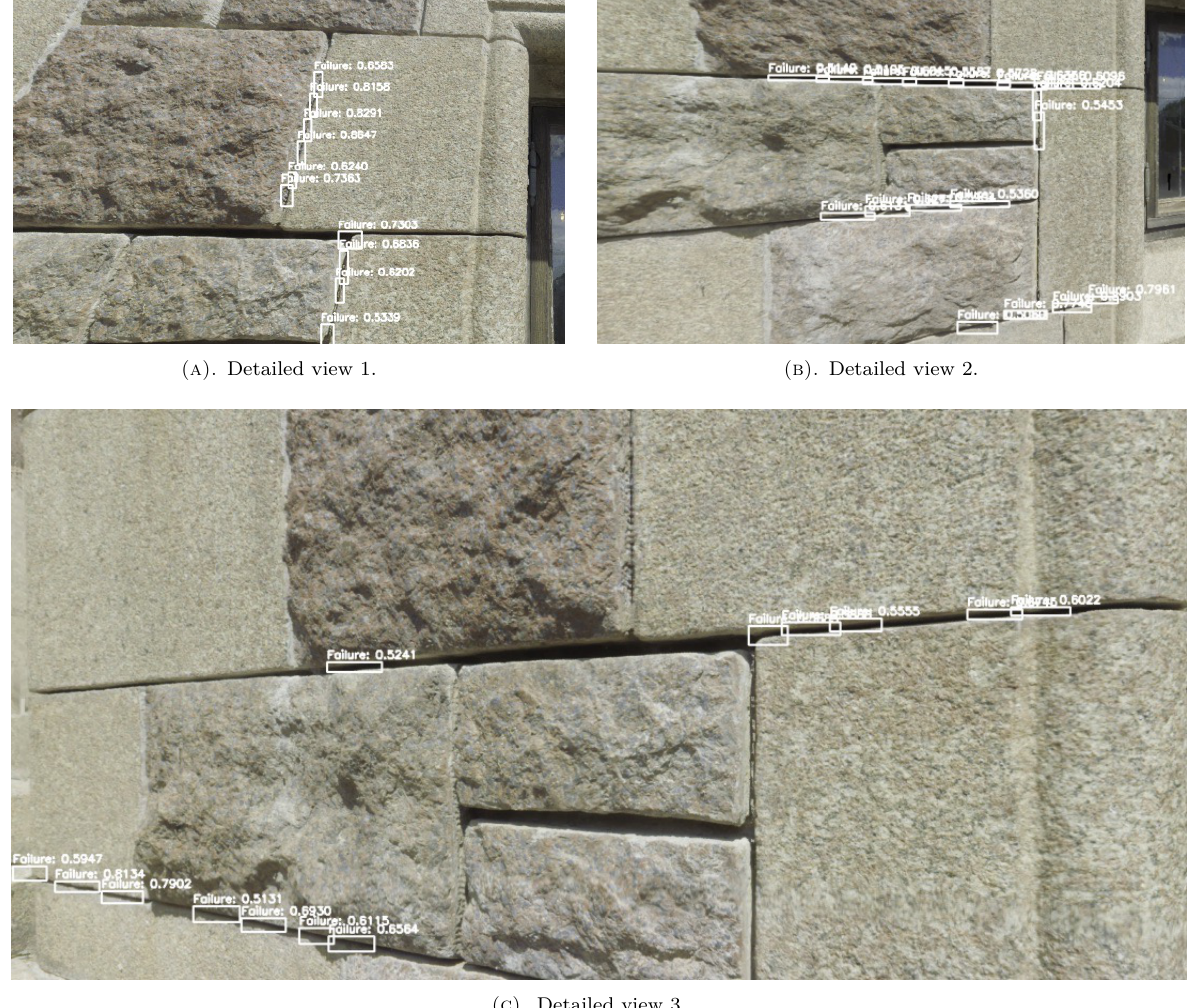
Figure 4. Detailed views. Credit: Anders Jansson, all rights reserved.